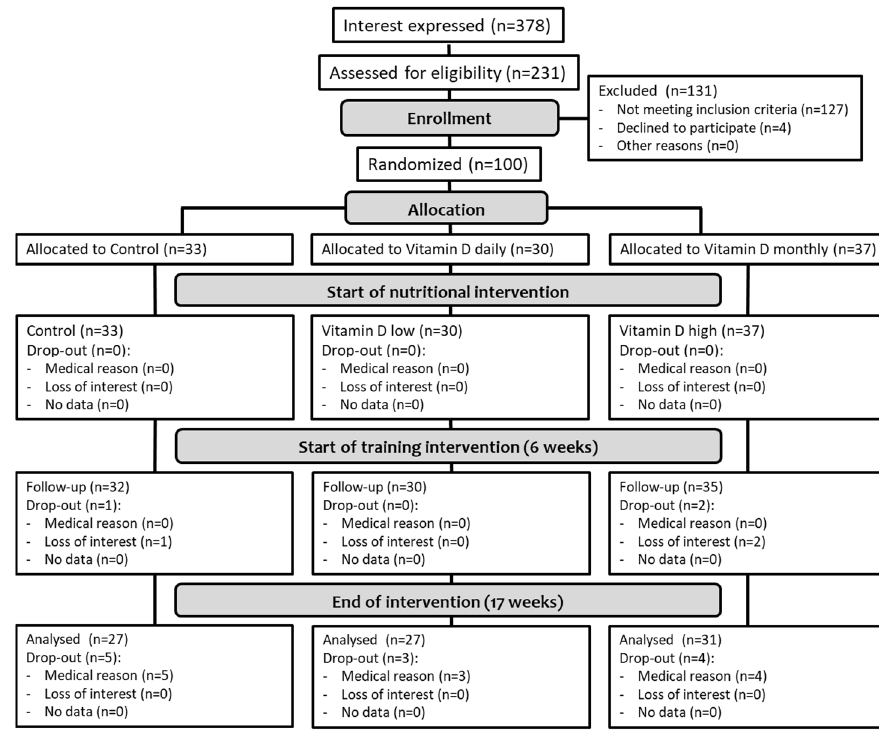
Figure 2. Participant flow chart.